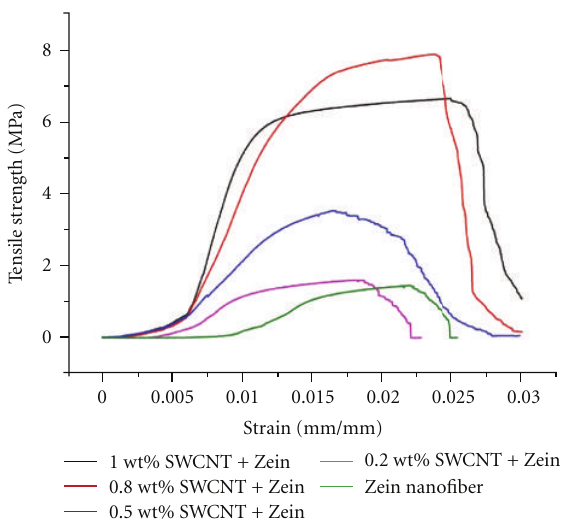
Figure 4: Typical tensile stress-strain curves of Zein nanofiber and Zein-SWCNTs nanocomposite Sca ff olds.